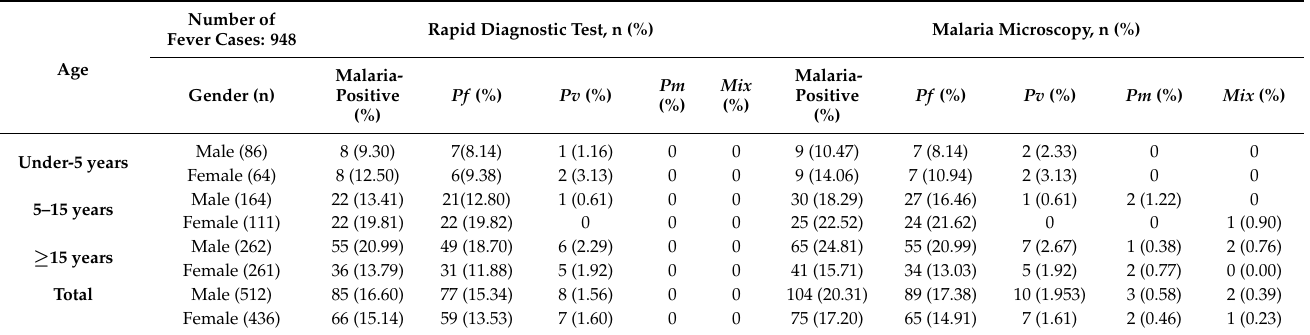
Figure 3. Thick smear showing Plasmodium malariae trophozoites ( A , B ) and their respective magnified images ( C , D ). Table 1. Age group- and gender-wise malaria cases diagnosis using RDTs and